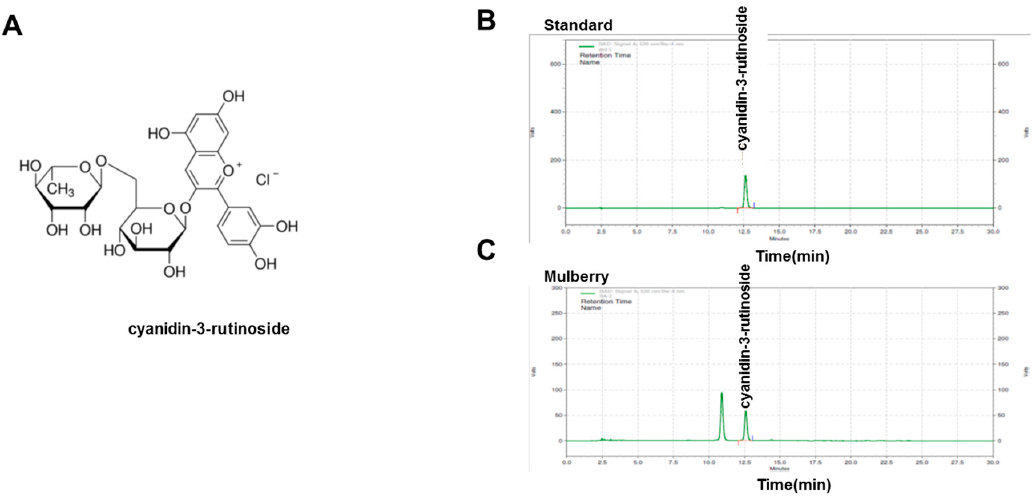
Figure 1. HPLC analysis of mulberry extracts. ( A ) Chemical structure of C-3-R. Chromatograms for C-3-R was analyzed for standard solution ( B ) and mulberry extracts ( C ). C-3-R, cyanidin-3-rutinoside.